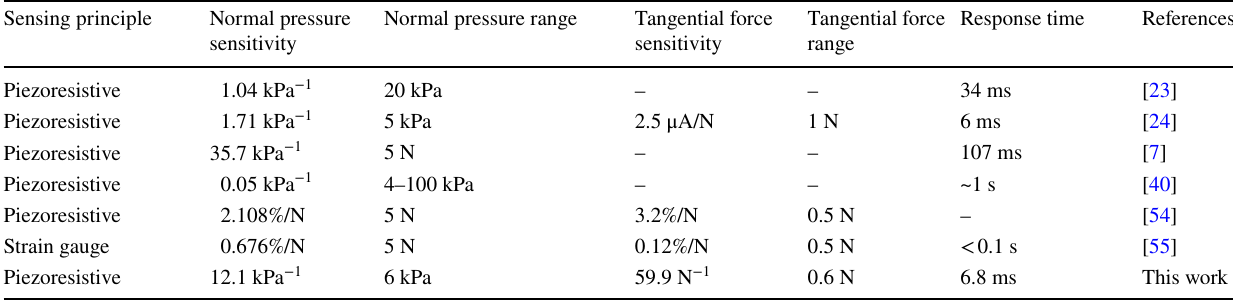
Table 1 Performance of relevant e-skin sensors reported recently Sensing